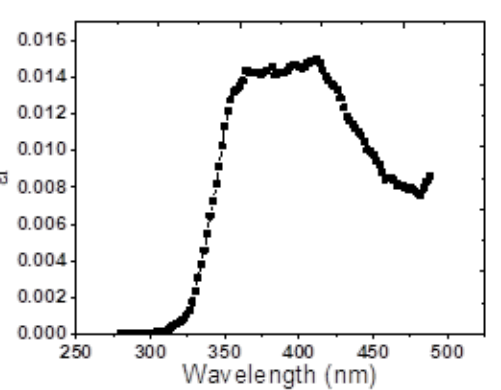
Figure 6: Relation between wavelength and optical refractive index.